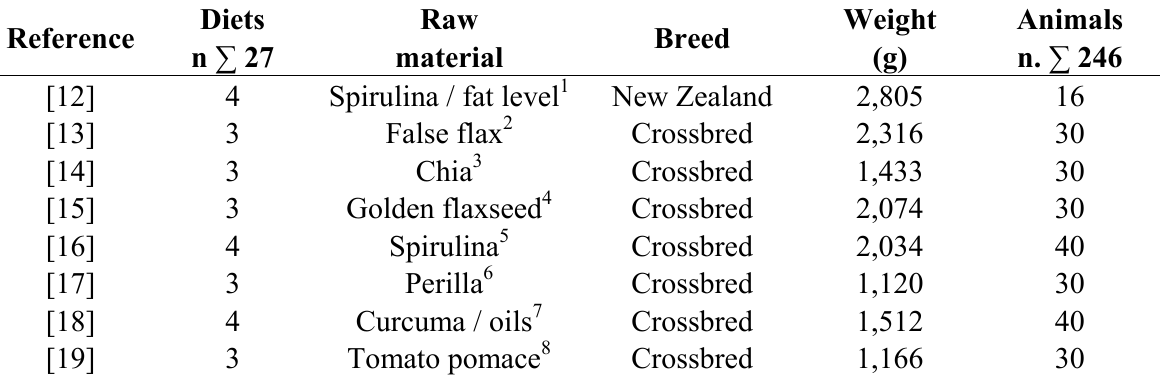
Table 1. Data set